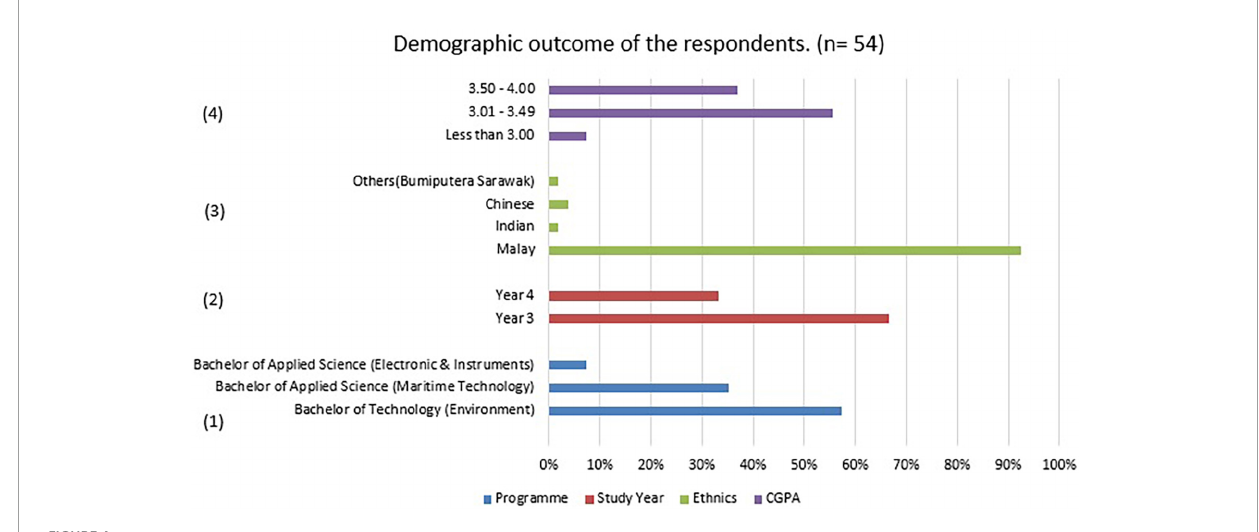
FIGURE4 The demographic result of the user (respondents) of teaching aid